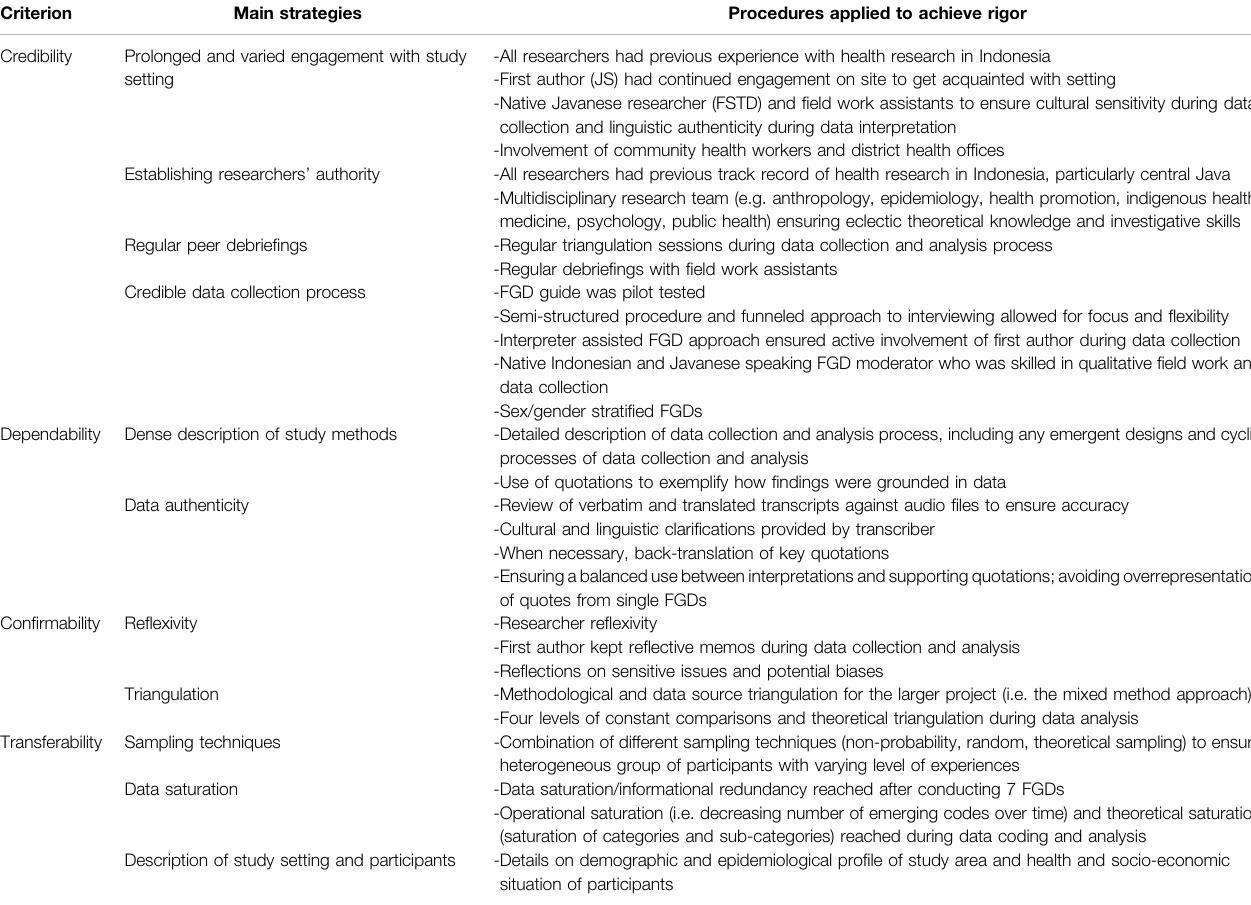
TABLE 1 | Trustworthiness strategies and